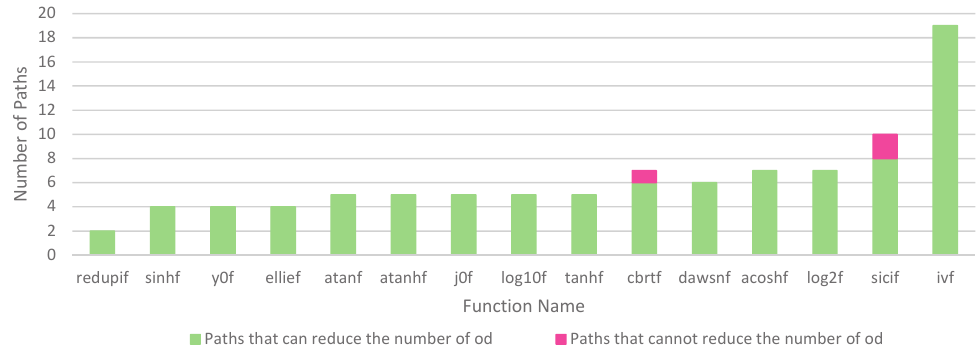
Figure 6. Overview of the Effectiveness of Quantity